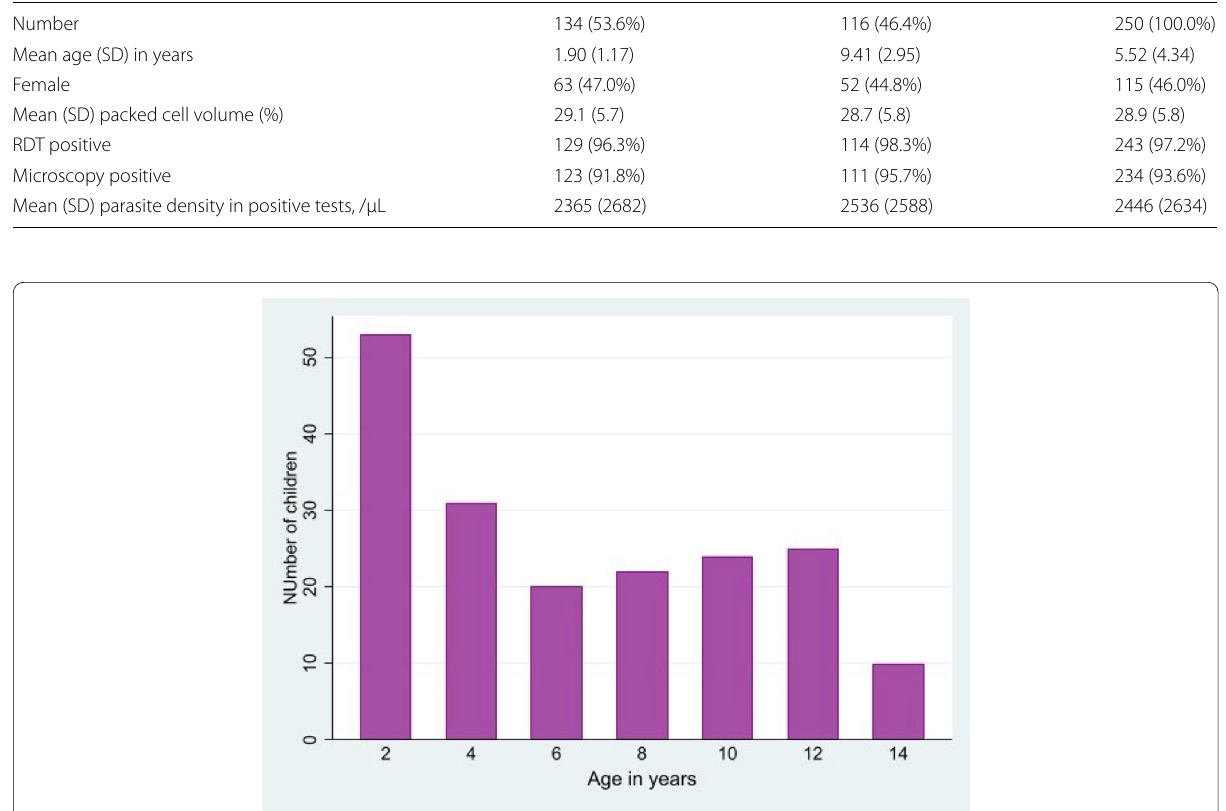
Fig. 1 Age distribution of febrile children attending a primary health center in Owo, Nigeria ( n